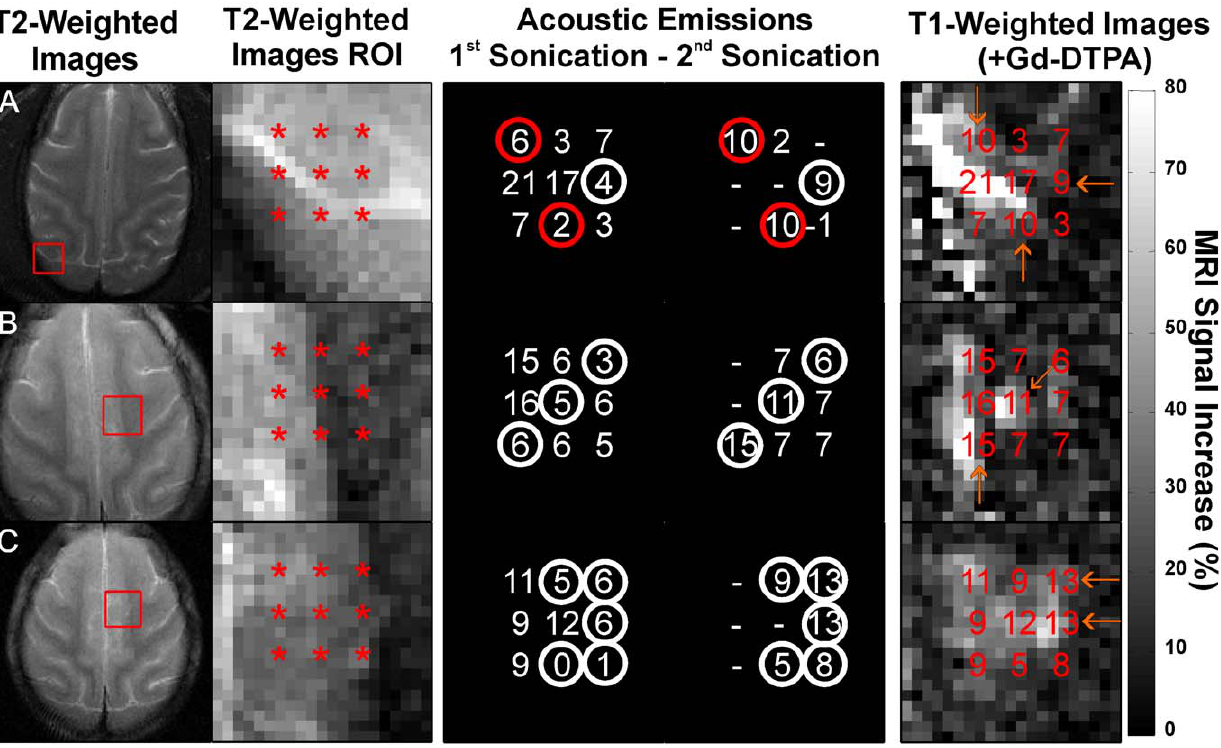
Figure 8. Sonication optimization. (A) Example where the pressure amplitude was increased by 10 kPa at select subsonications in a visual cortex sonication in monkey # 4. The harmonic emissions achieved during the first and second sonications (in Np ? Hz) are noted for each subsonication target. Two of five targets that were sonicated twice overlapped with a sulcus (red circles) and showed a large increase in harmonic emissions with the second sonication. From the other targets only one showed significant increase (circled). (B) Similar experiment performed in the cingulate cortex in monkey # 5. In this example the pressure amplitude was increased by 15 kPa for the second sonication. Three of the locations showed a strong increase in harmonic emissions (circled). (C) Similar experiment performed in the cingulate cortex in monkey # 5, but instead of increasing the pressure amplitude, the second sonication used five times the microbubble dose (circles indicate the most pronounced increase in harmonic emissions). Arrows indicate strong contrast enhancement at the targets with pronounced increase in the harmonic emissions (Left images: T2- weighted images showing the location of the targeted volumes and the ROI; Right images: images showing contrast enhancement in T1-weighted images after Gd-DTPA injection).